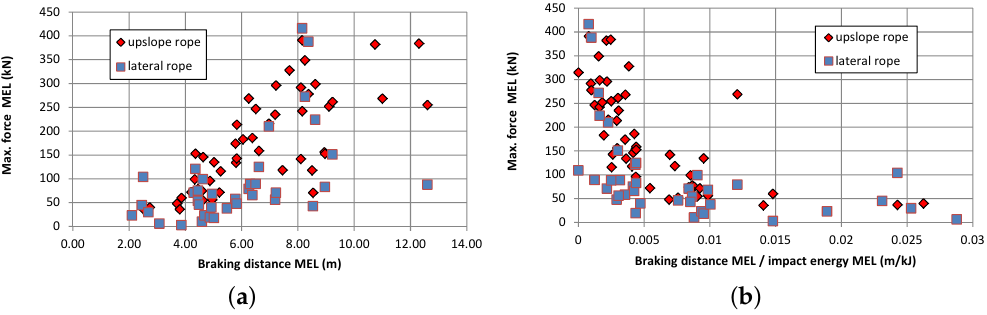
Figure 13. Maximum measured forces in upslope and lateral ropes during MEL with respect to ( a ) the braking distance and ( b ) the braking distance divided by the impact